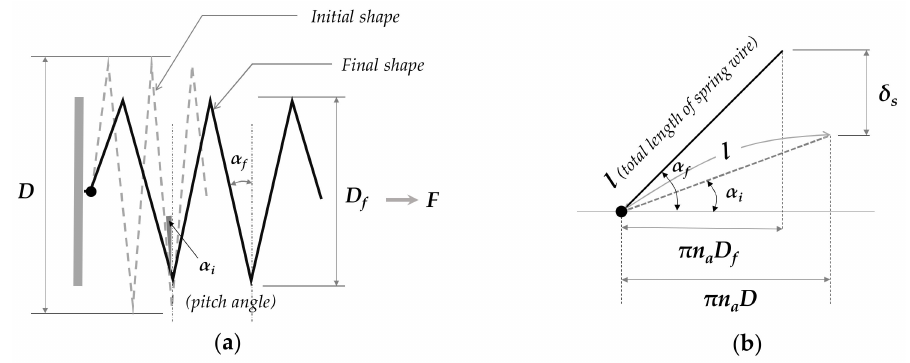
Figure 4. Parametric configuration of spring geometry: ( a ) Diameter change while in elongation; ( b ) Relationship between spring pitch angle and deflection